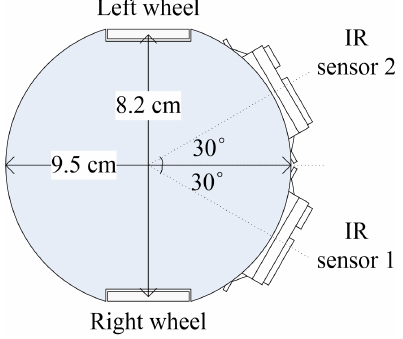
Figure 6. Brief top view of the